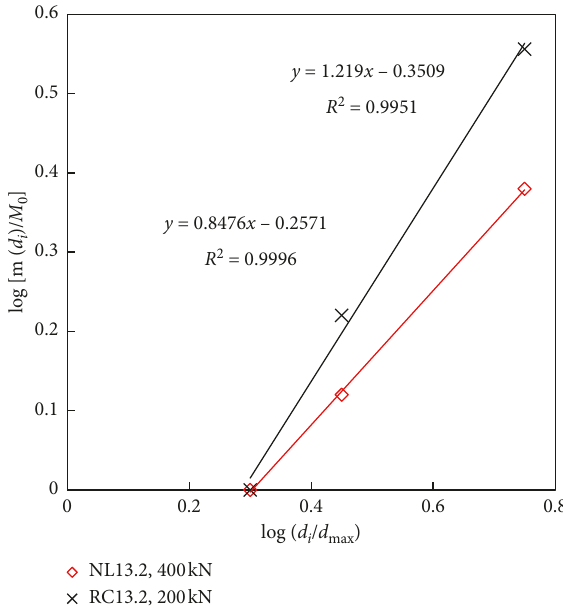
Figure 4: Relationship between lg ( d a particle diameter range of 9.5mm to 13.2mm with the crushing pressure of 200kN and 400kN (the values are expressed as absolute